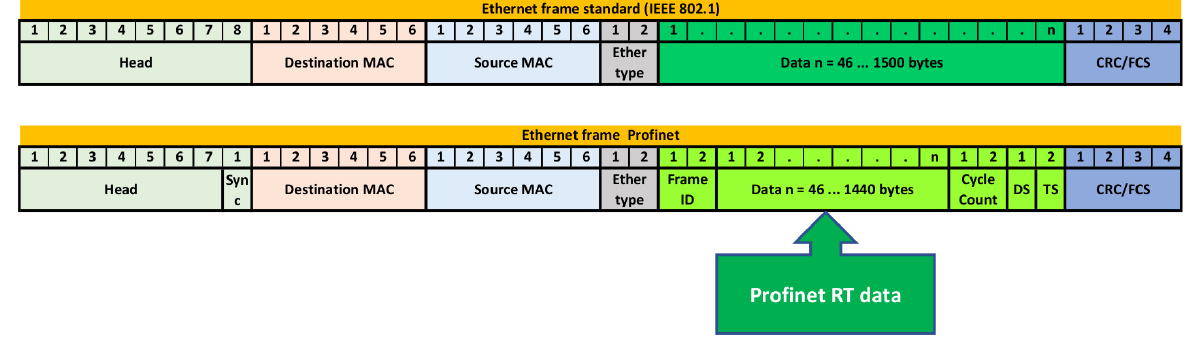
Figure 5. The structure of the Profinet ethernet frame.